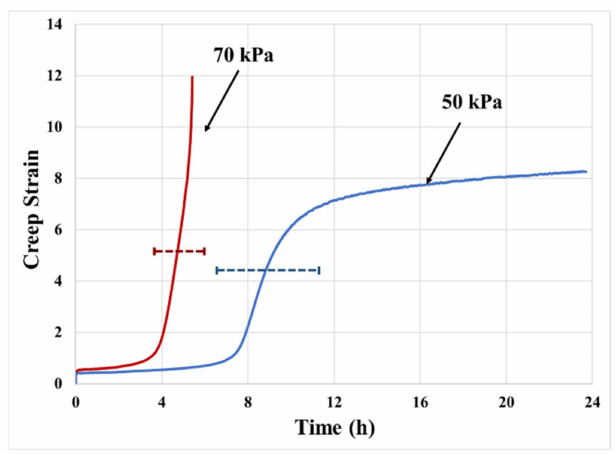
Figure 6. Effect of loading stress level on creep curve at 70 ◦ C (130 µ m thick